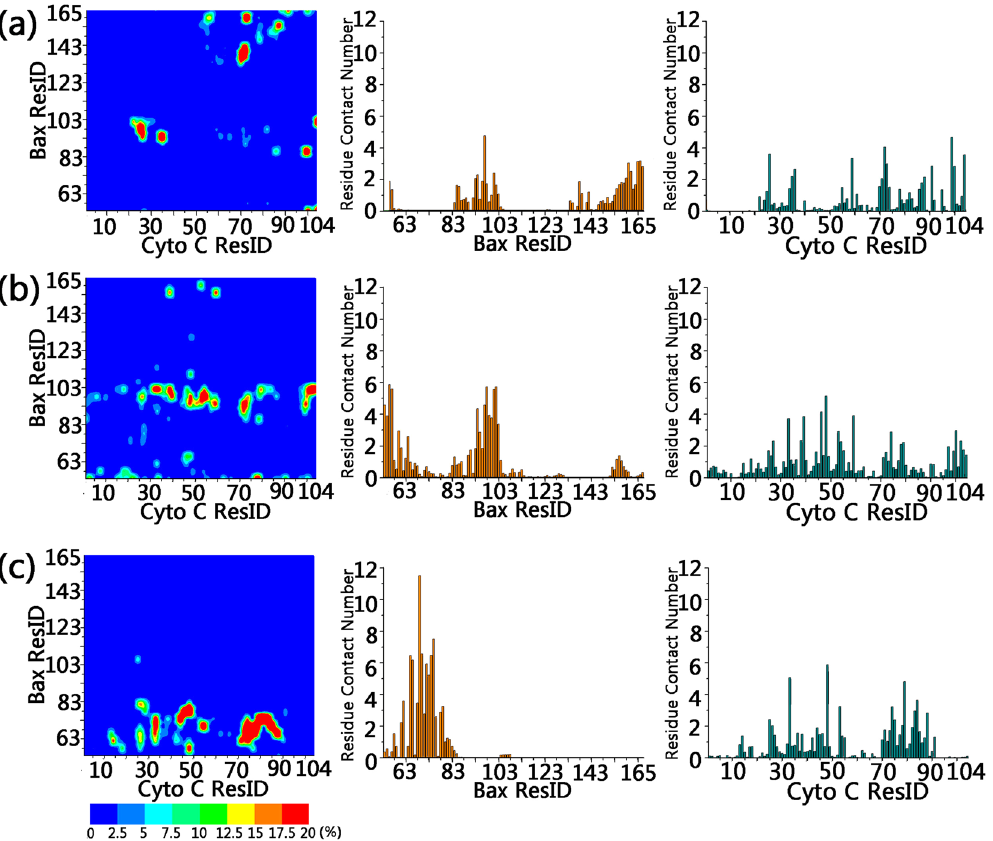
Figure 5. Residue-residue contacting matrix (left), and the residue contact number profiles for Bax (middle) and cytochrome C (right) at ① ( a ), ① ( b ) and ① ( c